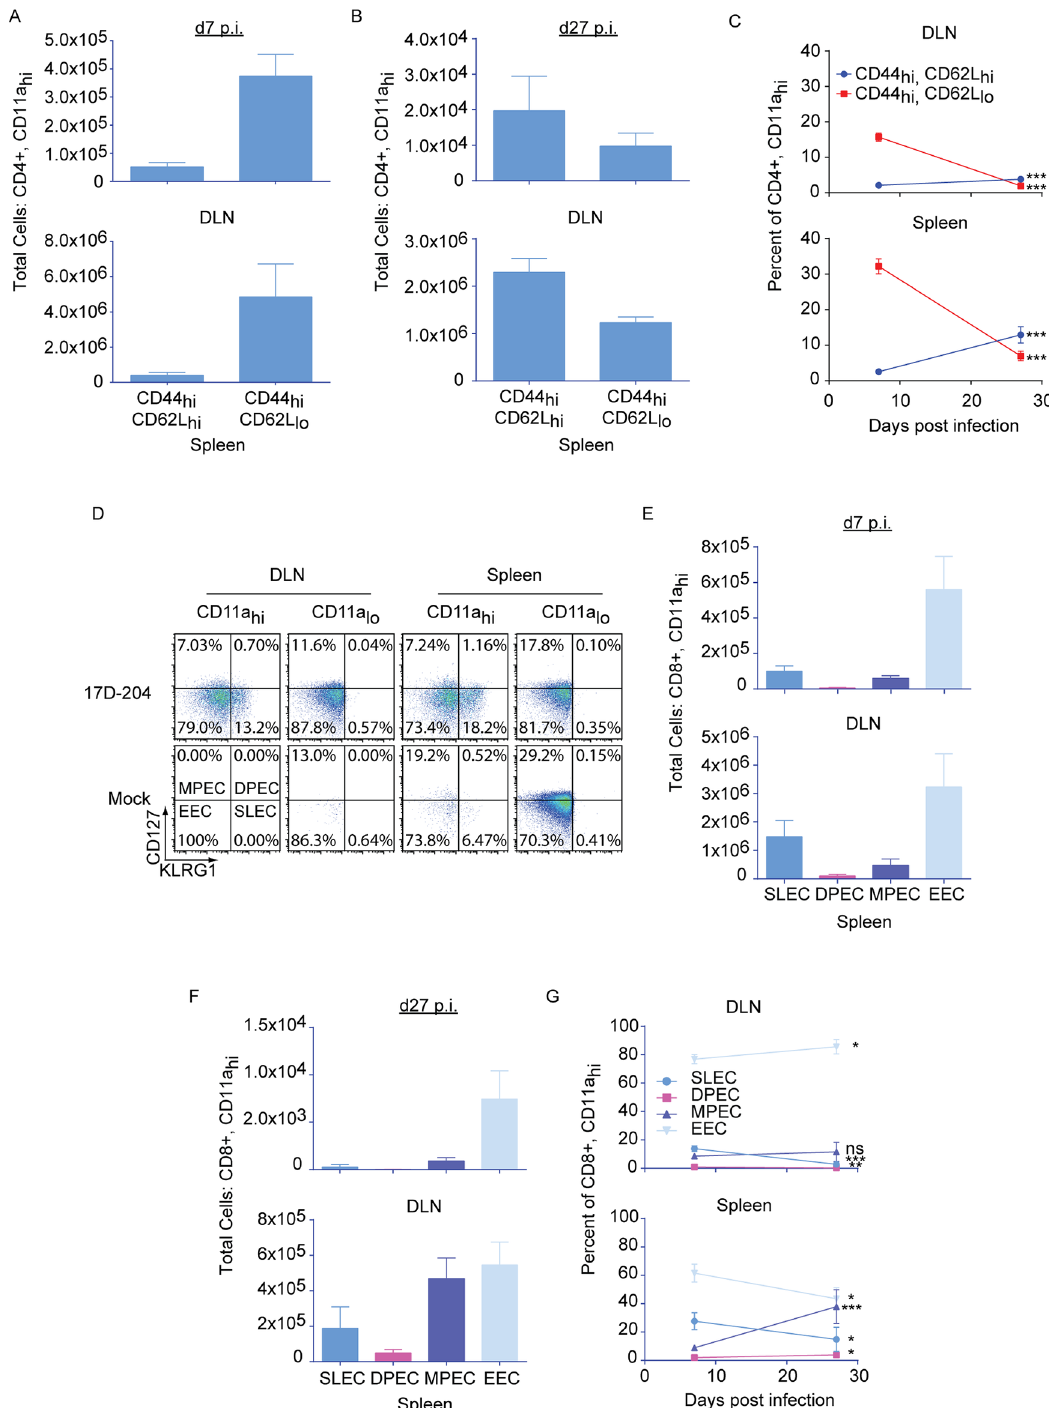
Fig 7. T cells responding to 17D-204 immunization express markers characteristic of the differentiation of long- lived memory. 5 – 6 week old mice were immunized with 17D-204. On d7 or d27 post immunization DLNs and spleens were harvested and cell surface expression of CD44 and CD62L was determined for (A-C) CD4+CD11a hi . (D-G) CD8 +CD11a hi cells were grouped as SLEC, DPEC, MPEC, or EEC by cell surface expression of KLRG1 and CD127. Results are from two separate experiments (n = 6 d7, 3 d27). Data are displayed as mean ± SD. ns, not significant; *** , p (cid:1) 0.0005; ** , p (cid:1) 0.005; * , p (cid:1) 0.05 as determined by a Student's t-test.